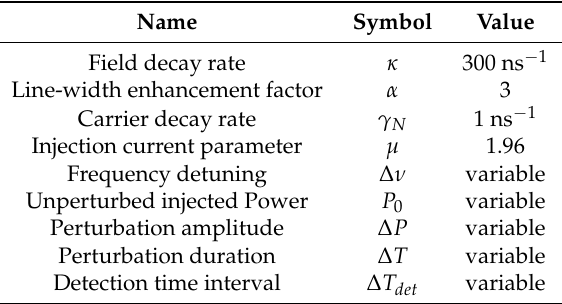
Table 1. Parameters used in the model simulations